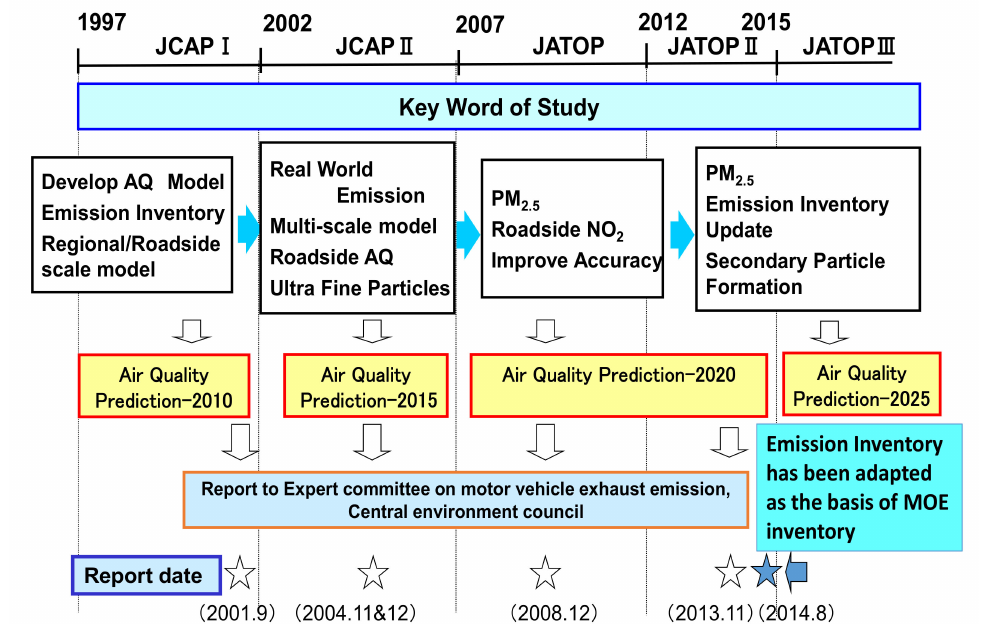
Figure 22. Contribution to policy making